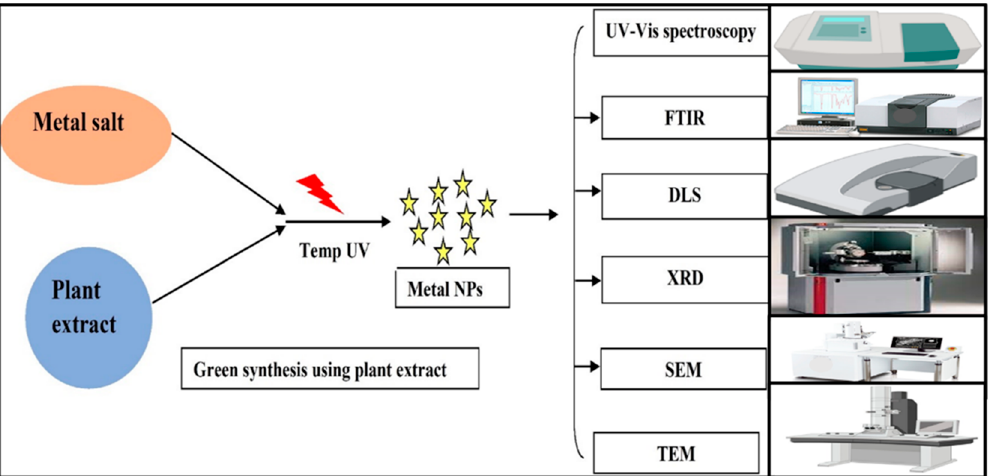
Figure 3. Schematic diagram of the preparation process of nanoparticles via plant